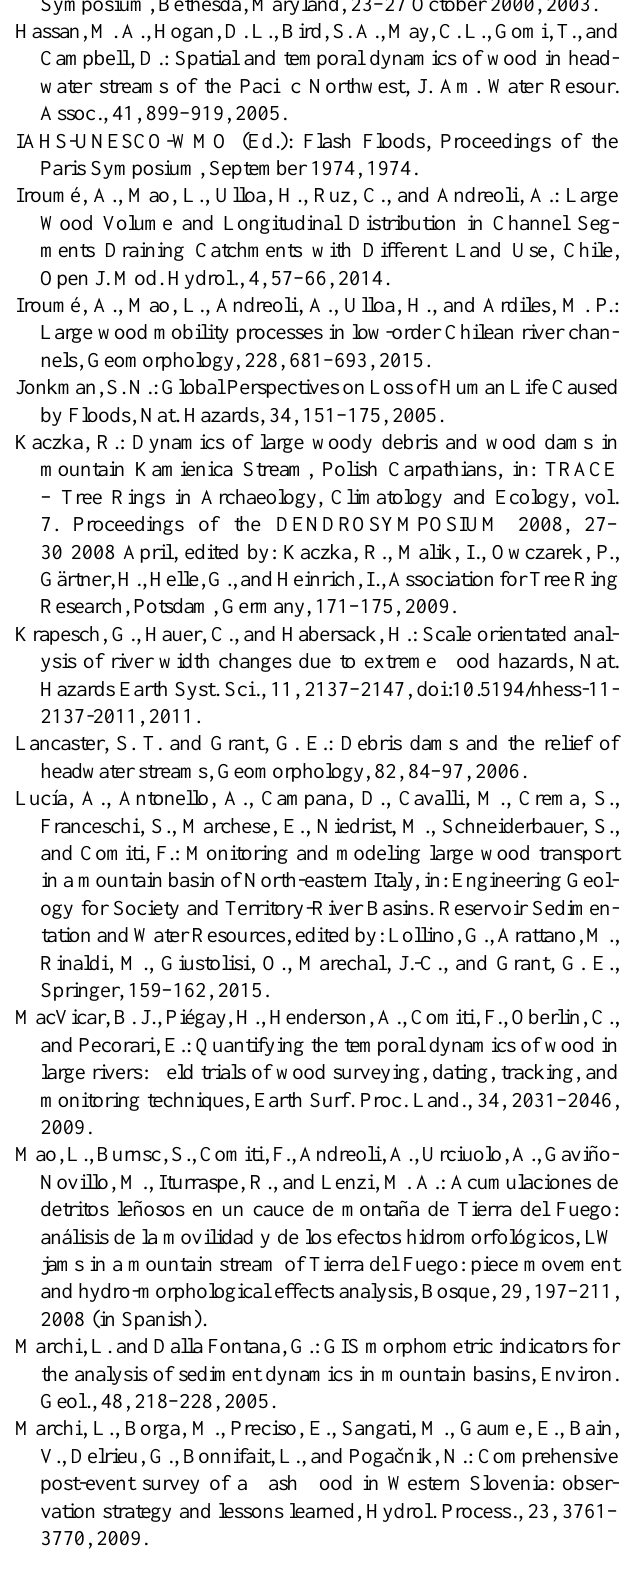
Castiglioni, G. B.: Le calamità naturali nelle Alpi., XXI